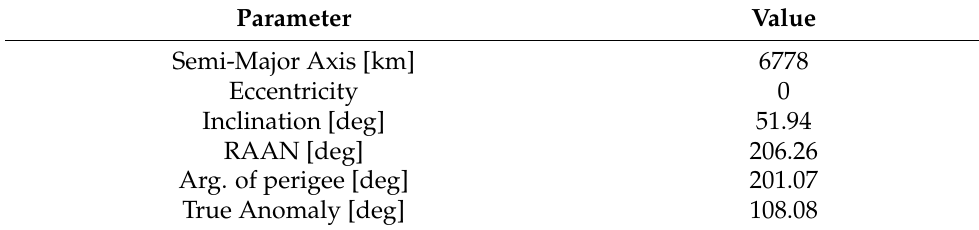
Table 4. Initial orbital parameters for the roto-translational maneuver.